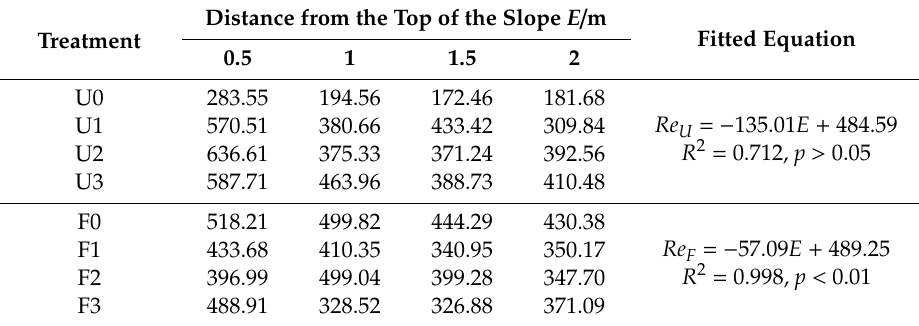
Table 5. Variations of Reynolds number with the distance from the top of the slope. Treatment